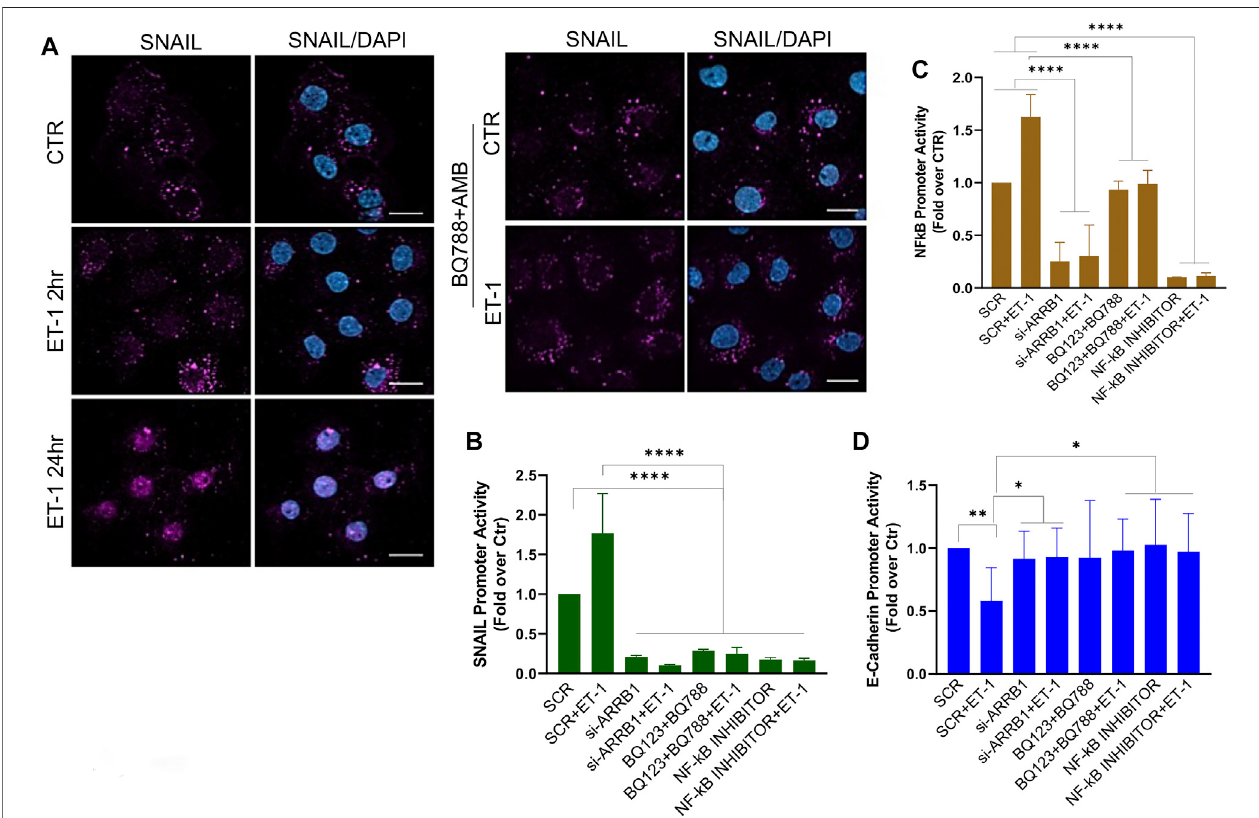
FIGURE 6 | ET-1 regulates MMT through NF- κ B/Snail transcription activity. (A) Representative images of IF analysis of MCs stimulated with ET-1 and/or BQ788+AMB 24 h and stained for Snail (violet) and DAPI (blu). si-SCR or si-ARRB1-transfected MCs stimulated with ET-1 and/or BQ123+BQ788 or NF- κ B inhibitor for 24 h (B) SNAILpromoteractivityanalysisor (C) NF- κ Bpromoteractivityor (D) E-cadherinpromoterwascalculatedasFire fl yLucvalue/GALenzymeactivity andshown as fold-over CTR. Histograms, the mean ± SD, n (cid:2) 6. One-way ANOVA and shown as fold-over CTR.